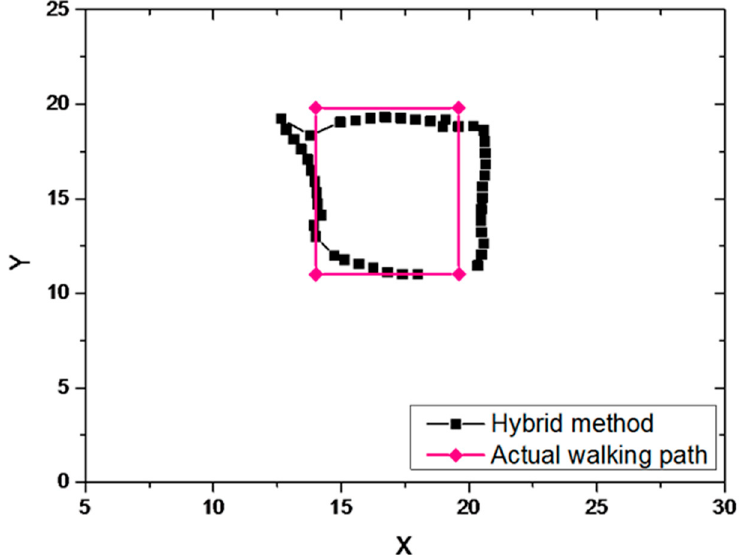
Figure 11. The estimated path and actual walked path of the hybrid method.